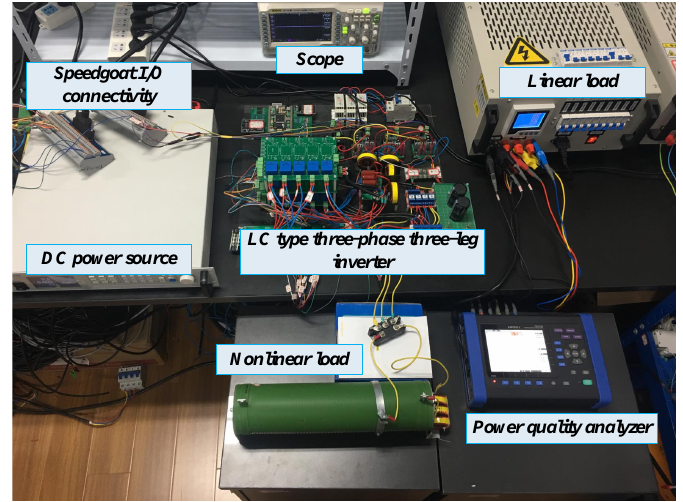
Figure 11. Experimental